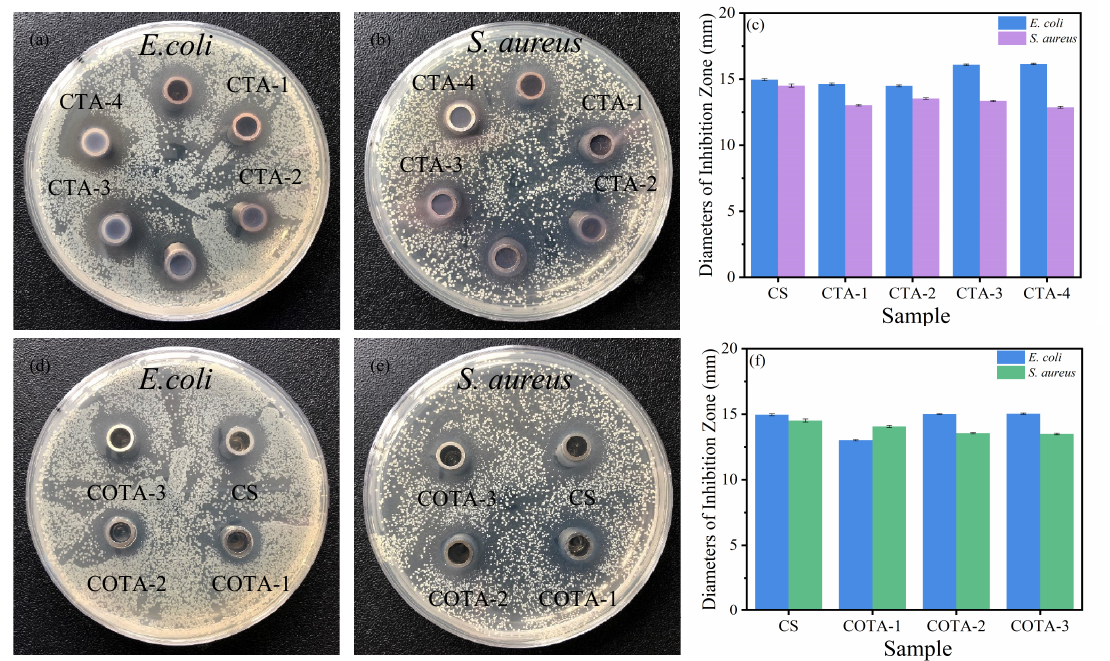
Figure 11. ( a , b ) The antibacterial effects of the CS and CTA solutions against Staphylococcus aureus ( S. aureus ) and Escherichia coli ( E. coli ); ( c ) the diameters of the inhibition zones of the CS and CTA solutions against S. aureus and E. coli ; ( d , e ) the antibacterial effects of the CS and COTA solutions against S. aureus and E. coli ; ( f ) the diameters of the inhibition zones of the CS and COTA solutions against S. aureus and E. coli .